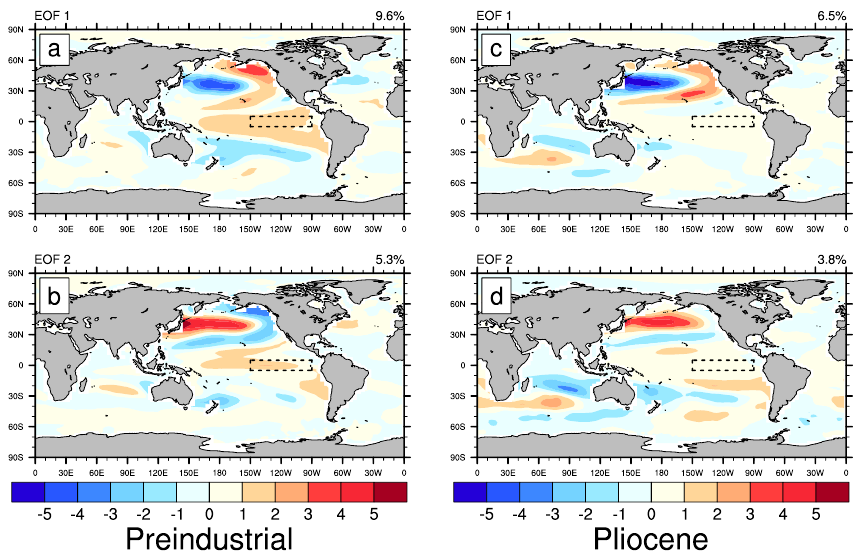
Figure 6. The first two EOFs of the global SST anomalies in NorESM-L for both the preindustrial simulation (left) and the Pliocene simulation (right). The percentage of the variance that each EOF explains is also